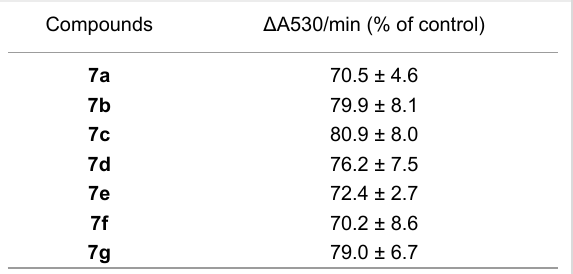
Table 2: The influence of the peptide conjugates of N-substituted tetrahydro- γ -carbolines on rat liver mitochondria swelling. a